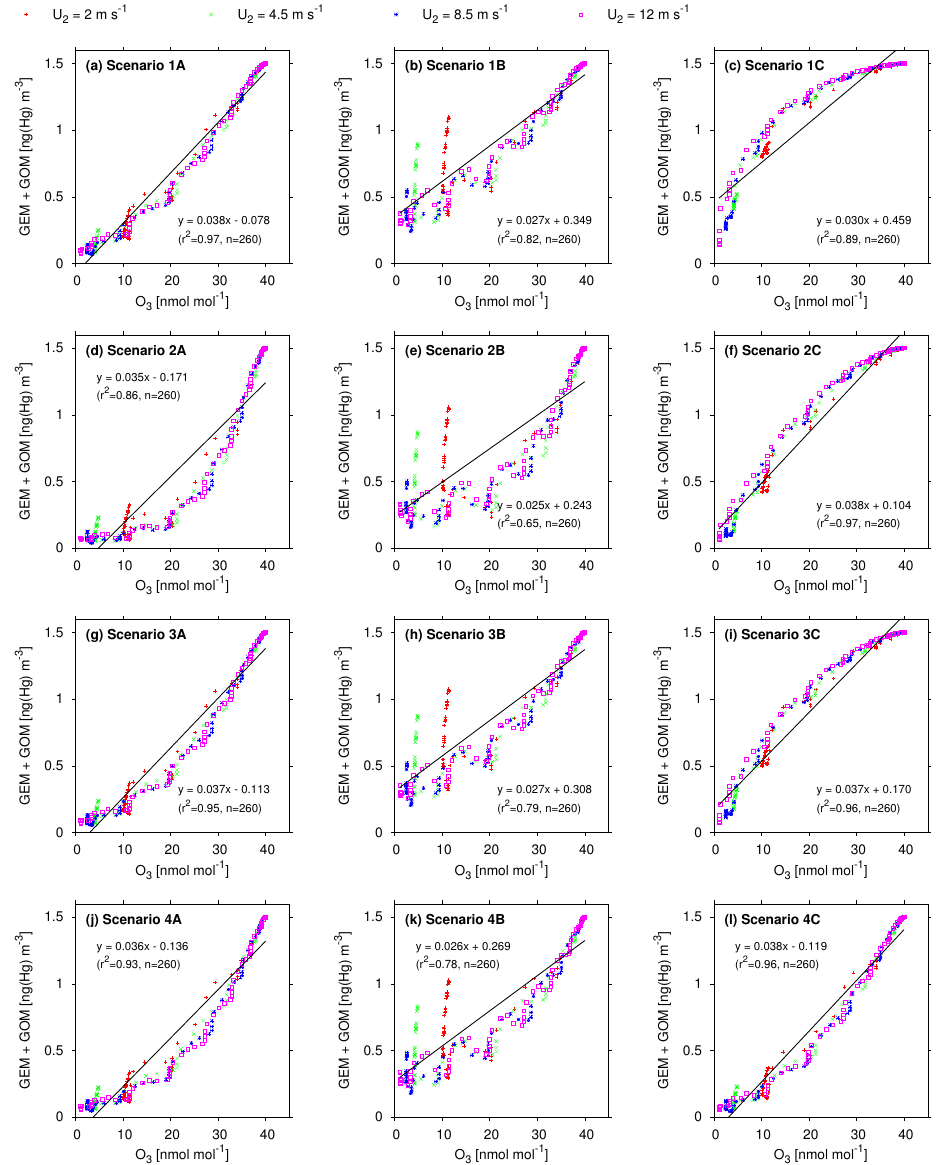
Fig. 10. Scatter plots of 3-hourly model output to show correlations between the concentrations of total gaseous mercury (GEM + GOM) and the mixing ratios of ozone at the height of 1.5m in the ambient air, plotted collectively from model runs at U 2 = 2 . 0ms − 1 , 4.5ms − 1 , 8.5ms − 1 , and 12.0ms − 1 for each scenario of mercury chemistry. Units for the concentrations of total gaseous mercury and the mixing ratios of ozone are ng(Hg) per standard cubic meter (at 0 ◦ C and 1atm) and nmolmol − 1 , respectively; the same as used for scatter plots of the same kind by Schroeder et al. (1998) and Ebinghaus et al.